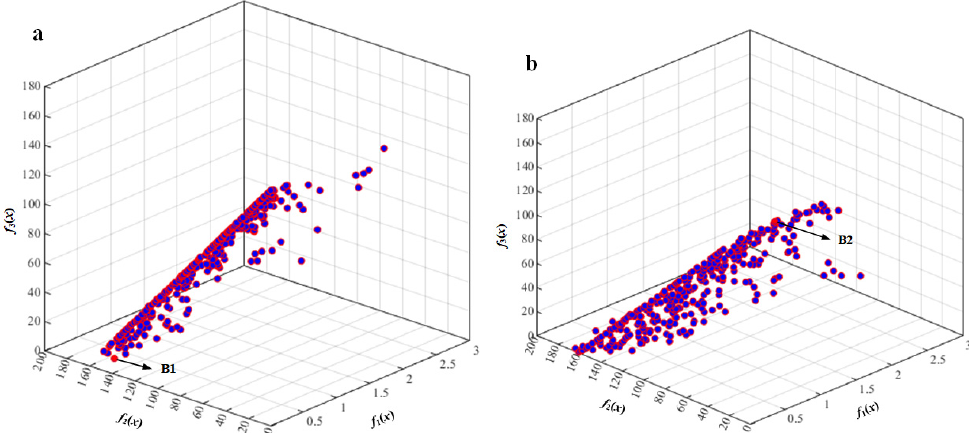
Figure 8. Pareto front obtained by tri-objective optimization using NSGA-III under engine rotation speed ω 2 = 220 Hz: ( a ) the optimal solution B1; ( b ) the optimal solution B2.